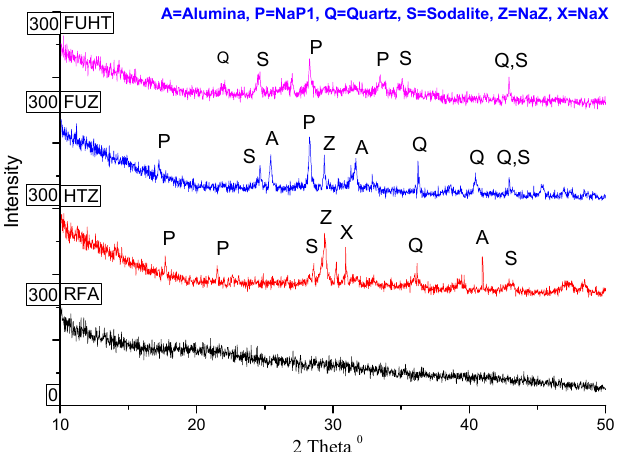
Figure 4. XRD crystallograms of RFA and its derived Na-Zeolites.